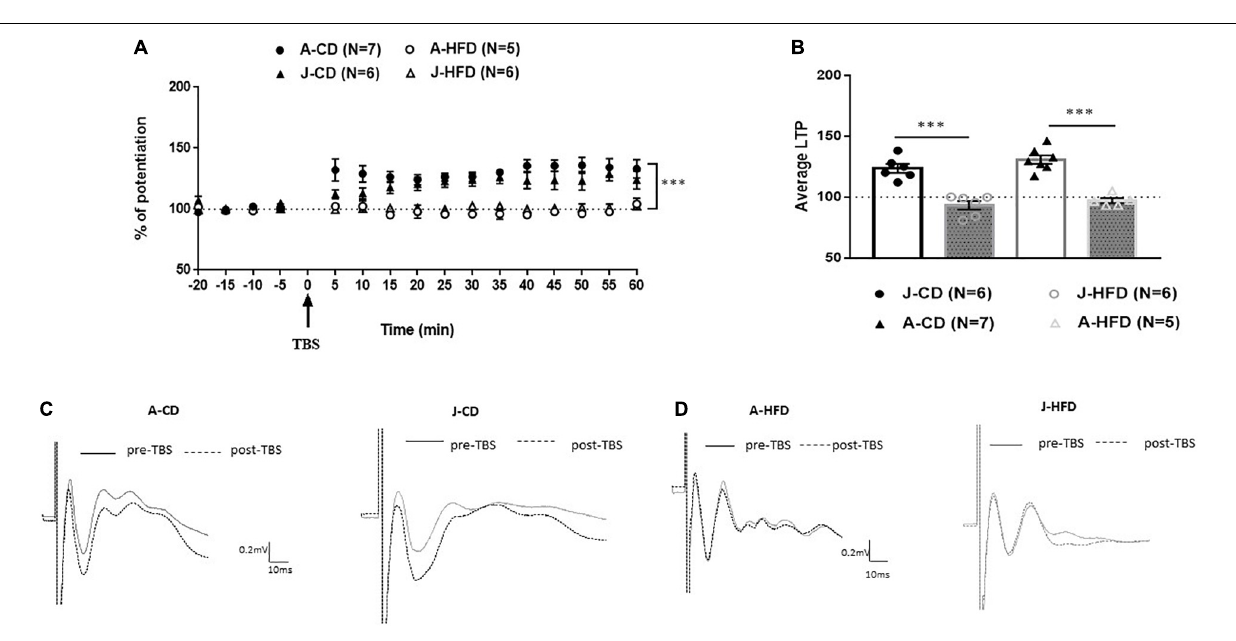
without an effect of Drug [ F (1, 34) = 0.713, n.s]. To